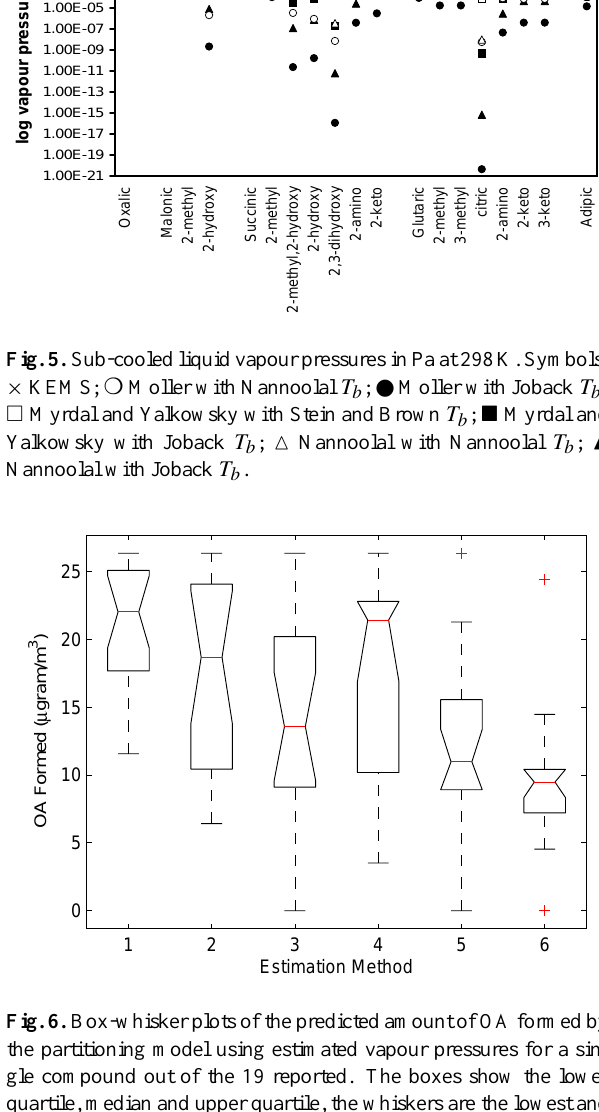
Fig. 6. Box-whisker plots of the predicted amount of OA formed by the partitioning model using estimated vapour pressures for a sin- gle compound out of the 19 reported. The boxes show the lower quartile, median and upper quartile, the whiskers are the lowest and highest values within 1.5 times the interquartile range. The base case uses experimental vapour pressure values with the concentra- tion of all components set to the value that gives 10.6µgm − 3 . Es- timation methods are: 1) Moller with Joback T b ; 2) Nannoolal with Joback T b ; 3) Myrdal and Yalkowsky with Joback T b ; 4) Moller with Nannoolal T b ; 5) Nannoolal with Nannoolal T b ; 6) Myrdal and Yalkowsky with Stein and Brown T b .